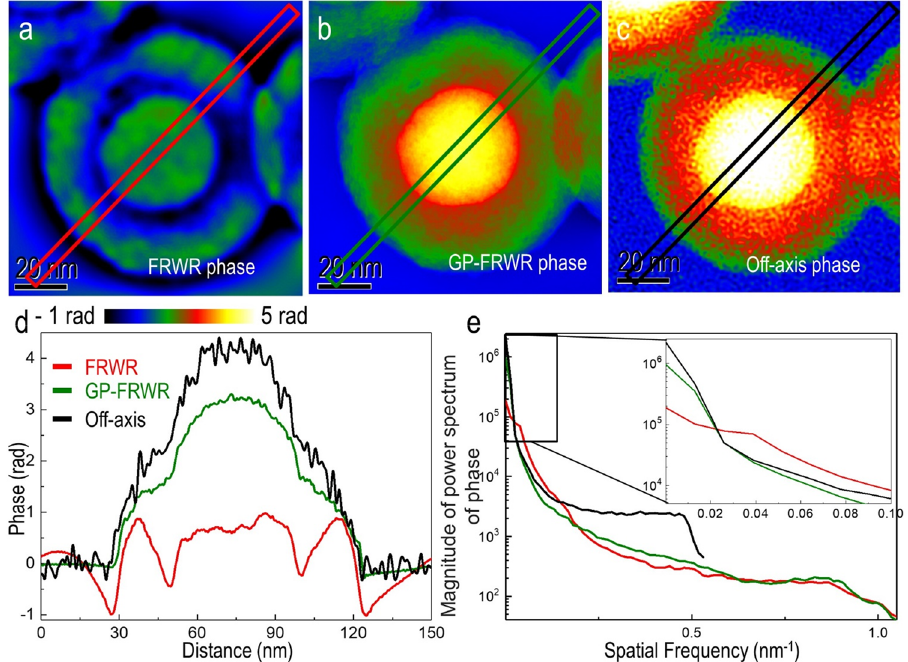
Figure 1. Phase images of Fe-filled C nanospheres were reconstructed using ( a ) FRWR , ( b ) GPFRWR, and ( c ) off-axis electron holography. ( d ) Line profiles extracted from the three phase reconstructions. ( e ) Radially- averaged power spectra of the three phase